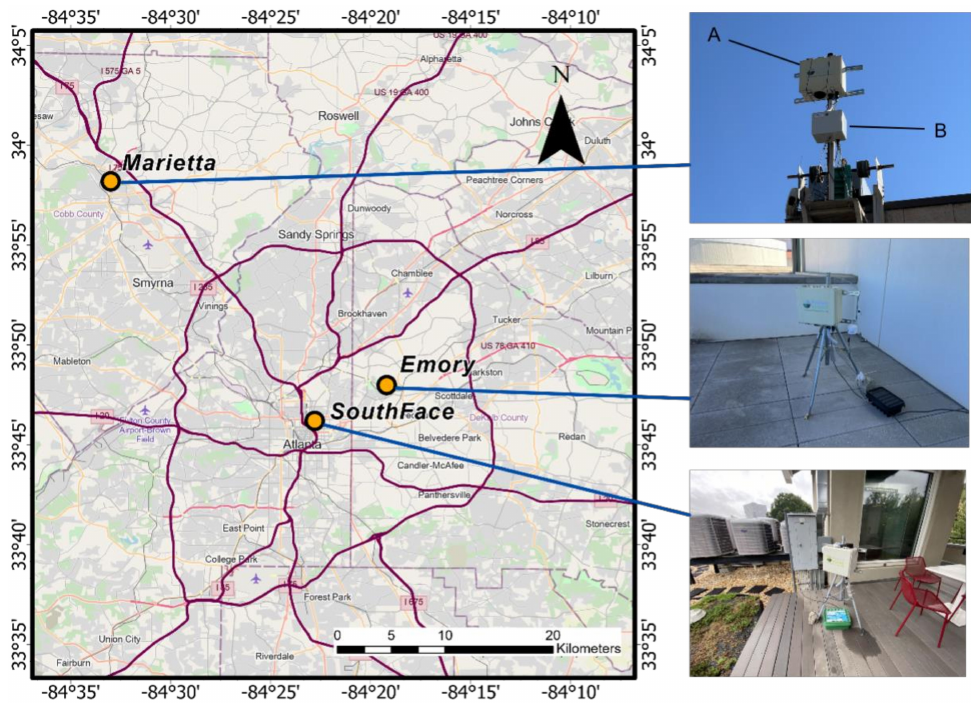
Figure 1. Study domain and sites. More descriptions on map. Device A is the APS-300 while device B is the